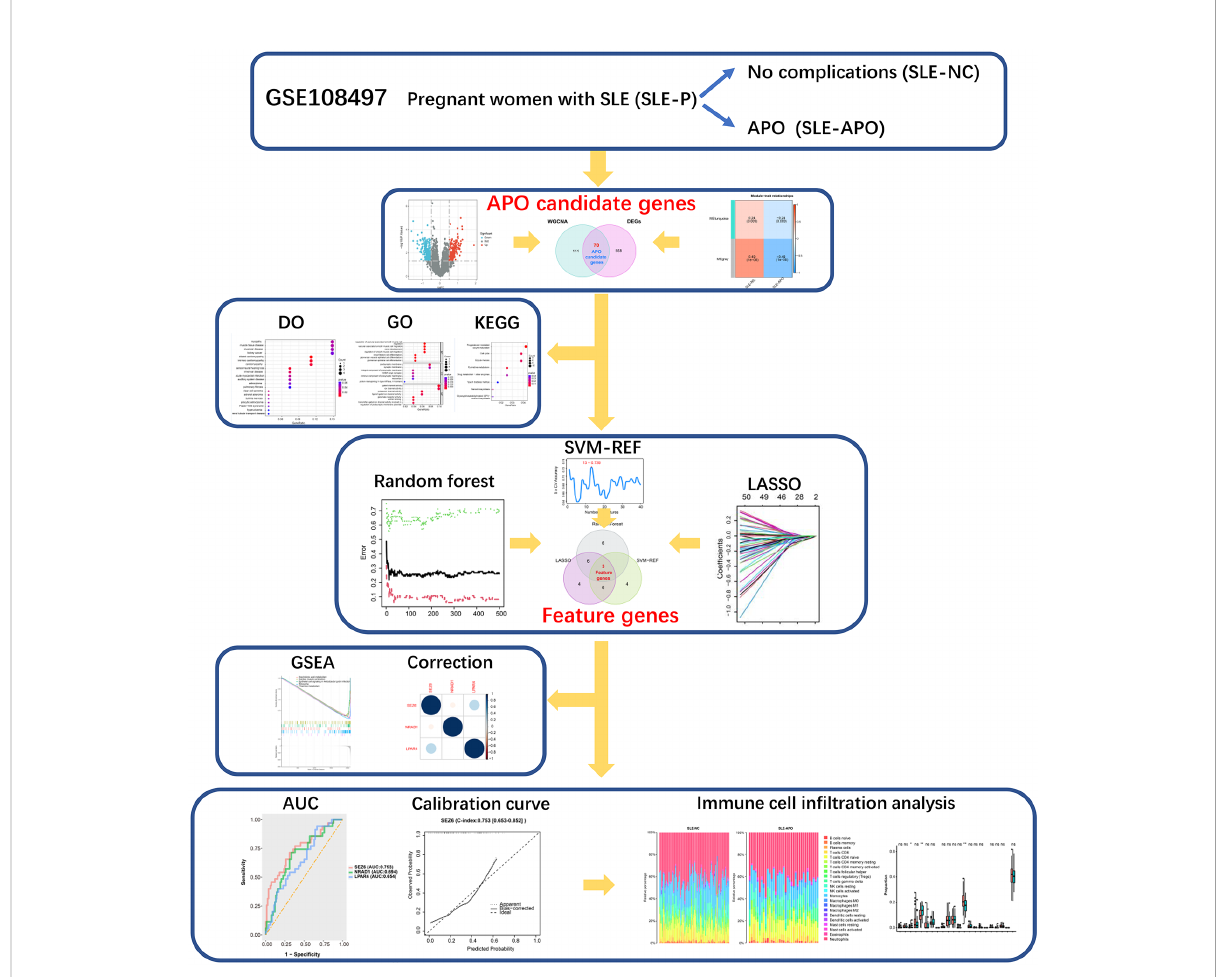
FIGURE 1 Flow chart of the data processing procedure. *P < 0.05, **P < 0.01, and ns, not signi fi